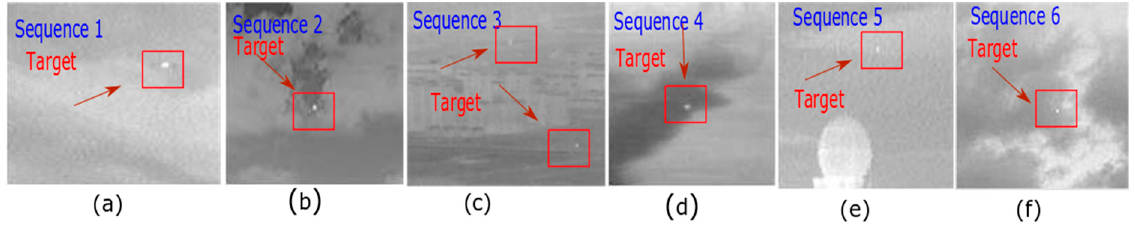
Figure 3. ( a – f ) are the six real infrared image sequences.